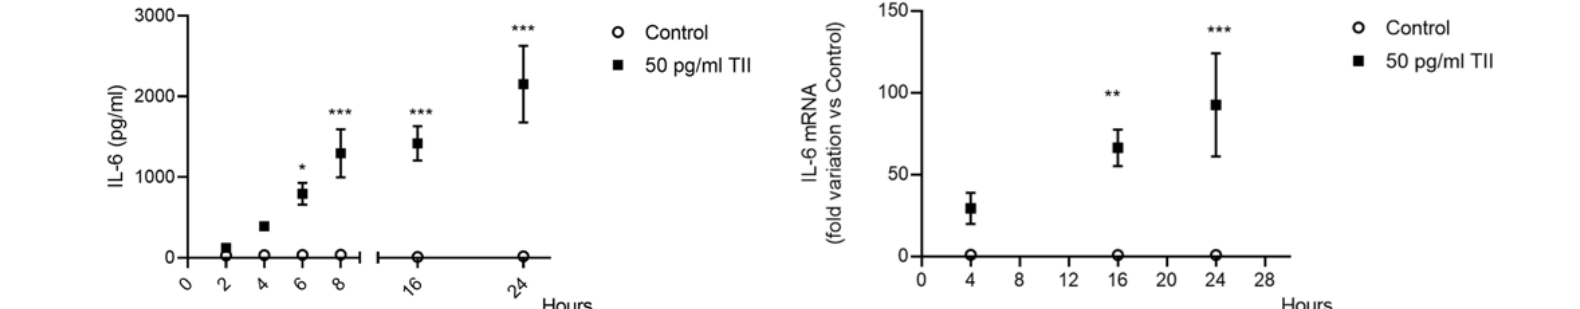
Figure 1: TII stimulatory effects on IL-6 expression and secretion. ( A ) IL-6 release was measured by a specific ELISA. Cells were treated with TII for different time points and the incubation medium was harvested and analyzed. ( B ) C20 cells were plated and treated with TII for different times. mRNA levels were evaluated taking the Control as calibrator. The experiment was repeated at least three times with similar results. Data are shown as pg/ml, mean ± SEM (n=11-12) or expressed as fold variation vs. Control, means ± SEM (n=11-12). Data were analyzed by two-way ANOVA followed by the Bonferroni's post hoc test. *, p<0.05; **, p<0.01; and ***, P<0.001, versus